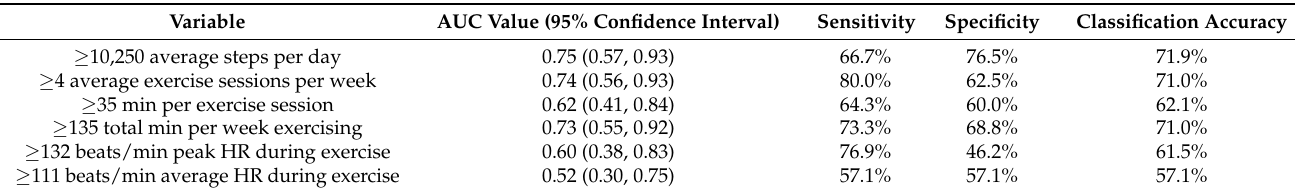
Table 2. Receiver operating characteristic, sensitivity, specificity, and classification accuracy to determine whether participants were cleared to RTP within 28 days after concussion for each exercise outcome variable.